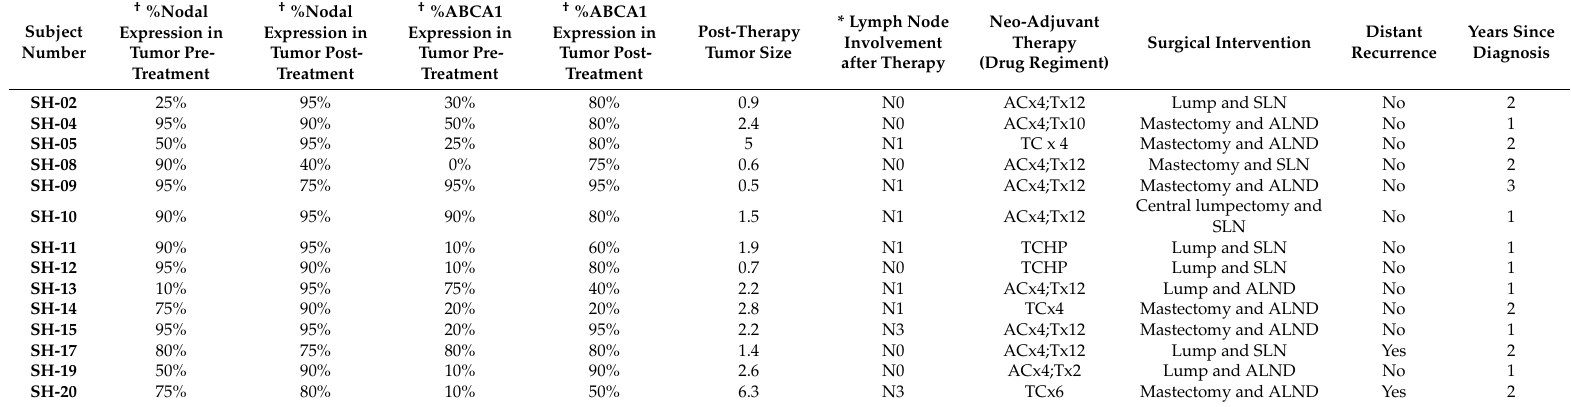
Table 2. Specific diagnoses, clinical measurements, treatment regimens and observations for the breast cancer patients’ tumors, with incomplete pathological responses, examined in this